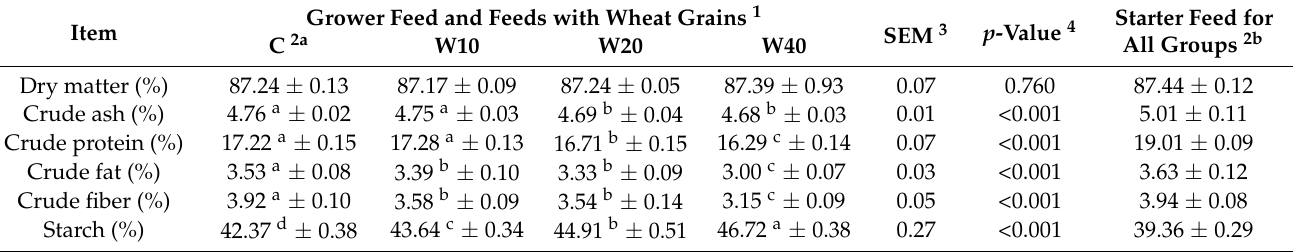
Table 1. Analytical composition of grower feed with and without wheat grain addition and starter